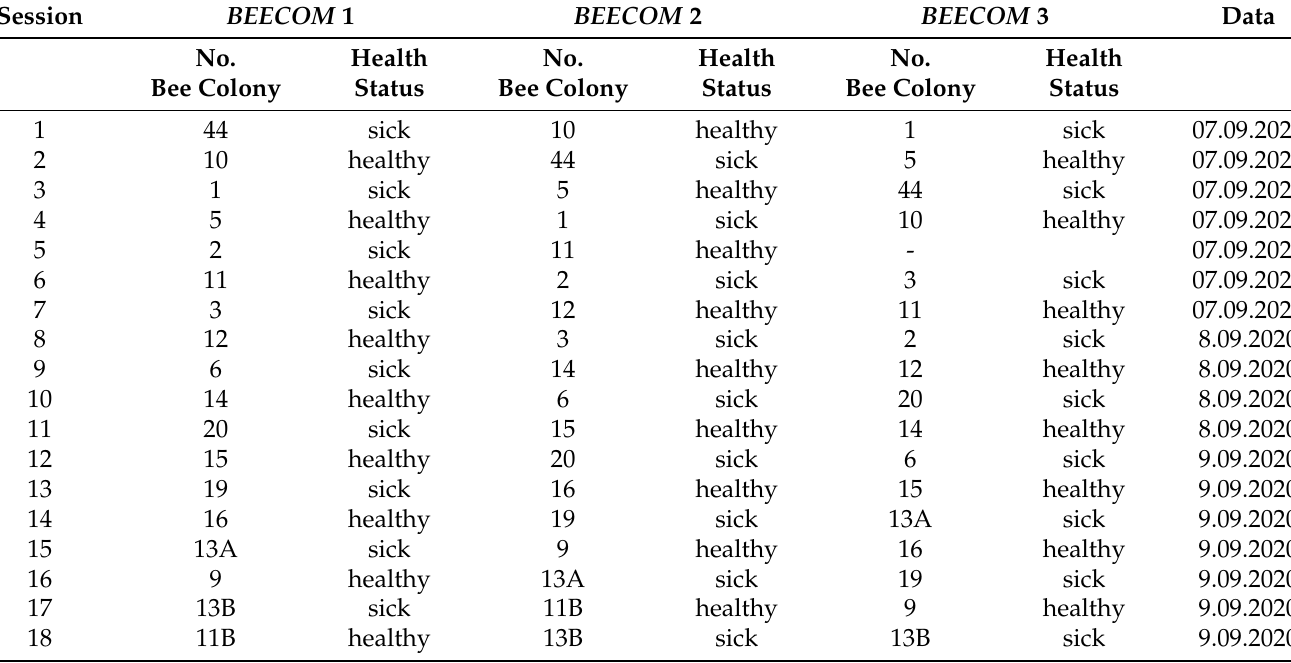
Table 2. The schedule of measurements taken, stating that each device shall test alternately sick and healthy bee colonies, and each device shall test all bee colonies participating in the